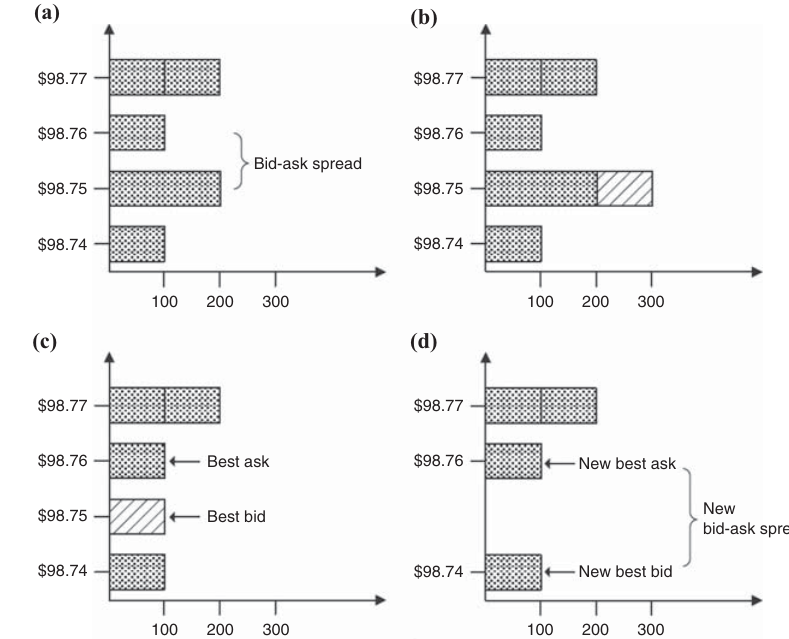
Figure 1. An example to show changes in LOB as time